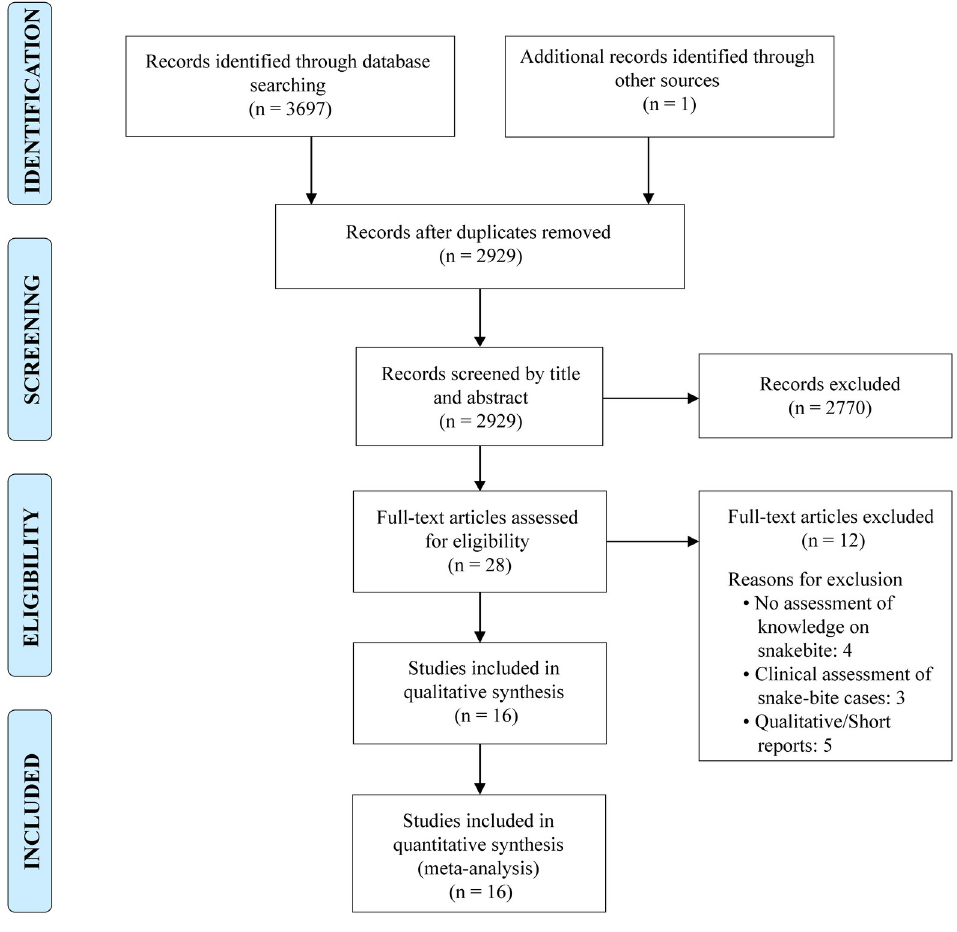
Fig 1. PRISMA 2009 flow